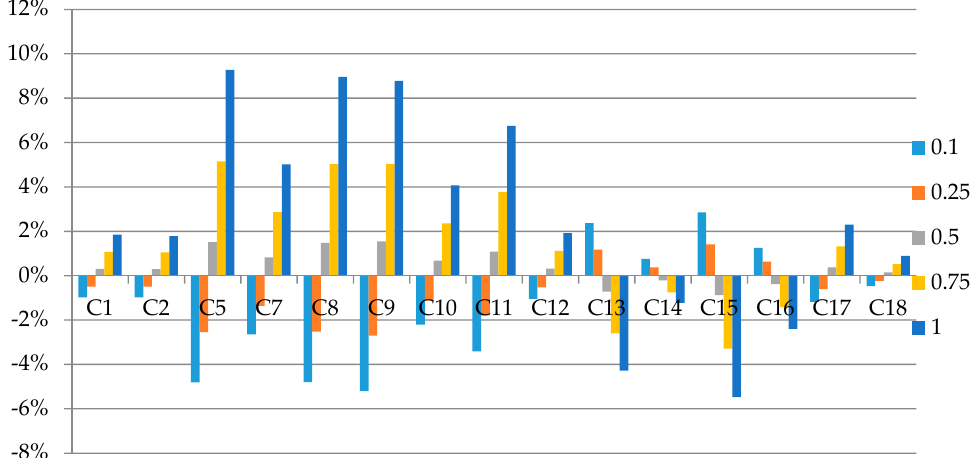
Figure 7. The e ff ect of the factor “financial Figure 7. The effect of the factor “financial support”. Figure 7. The effect of the factor “financial support”.